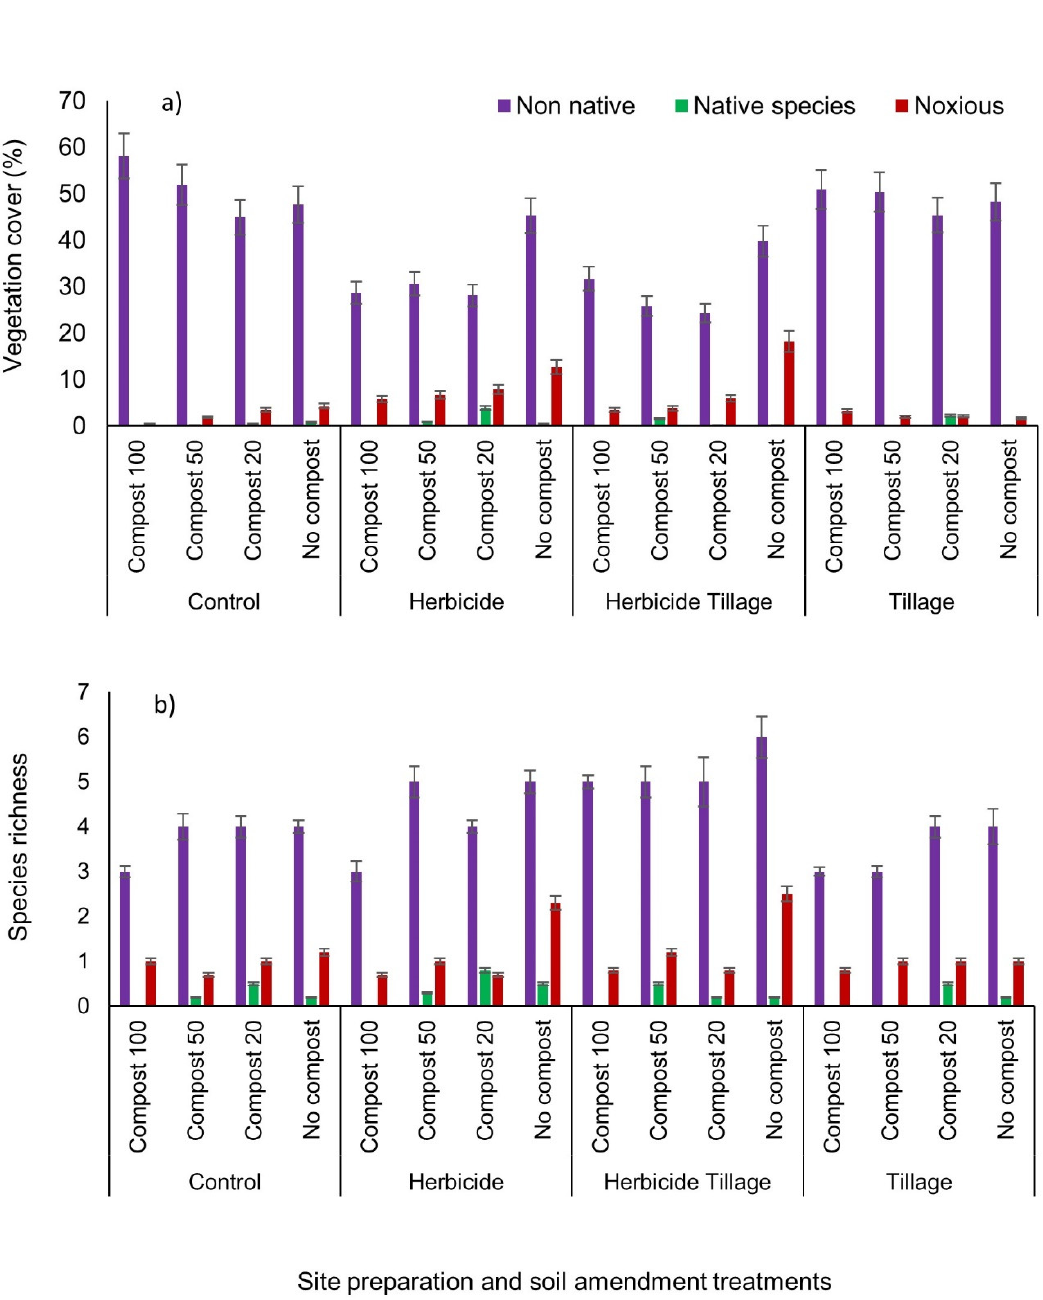
Figure 4. ( a , b ) Mean ( ± SE) percent cover and richness of native, non-native and noxious species by site preparations and soil amendments .